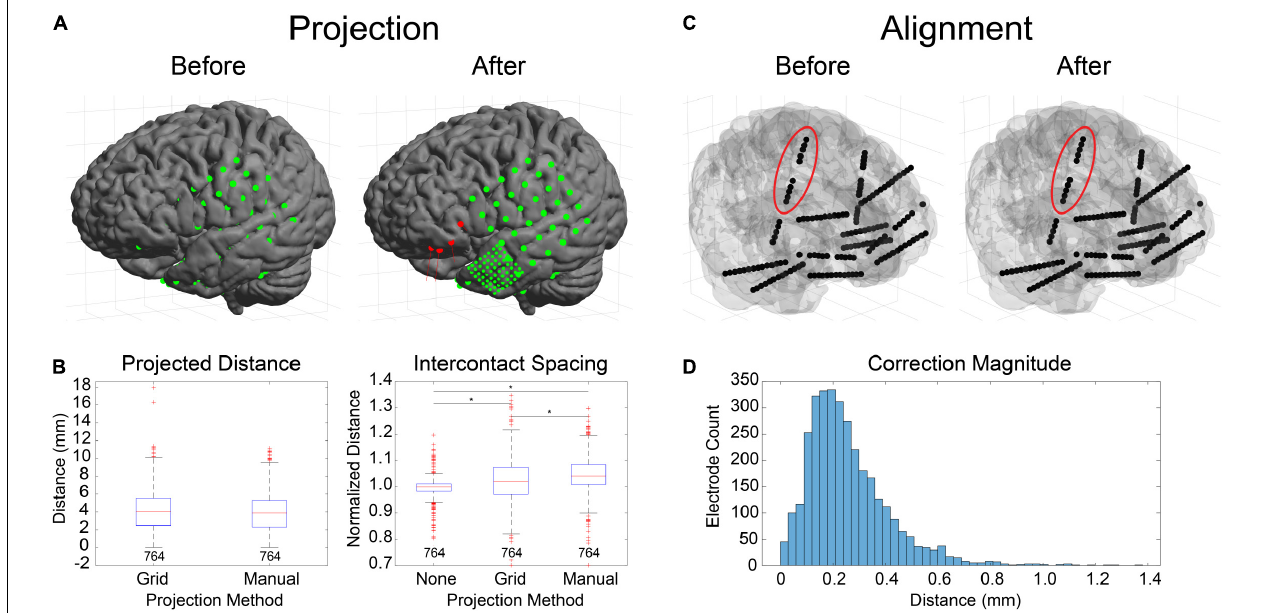
FIGURE 4 | Electrode projection and alignment results. (A) Example showing electrodes before (left) and after (right) projection using the “manual” projection method. An 8 × 8 ECoG grid and multiple strips (10-mm spacing) along with an 8 × 8 mini-ECoG grid (3-mm spacing) are visible. Projection vectors (red lines) are shown for 4 selected electrode contacts (red spheres) that represent the normal vector to the “projection” surface (not shown). (B) Projection distances for 10 datasets (764 electrodes) for the “grid” (Hermes et al., 2010) and “manual” projection methods are shown (left). The median and ranges were 4.07 (0.00–17.95) and 3.88 (0.00–11.17) mm, respectively. No differences were found between the two methods (KW test, df = 1, χ 2 = 3.14, p = 0.076). Intercontact spacings were measured for unprojected electrode contacts, as well as for the two projection methods (right). The median and ranges were found to be 1.00 (0.45–1.78), 1.02 (0.38–1.93), and 1.04 (0.44–1.99) mm, respectively. Asterisks indicate significance (pairwise rank sum, p < 0.01). Separations for the “grid” and “manual” methods were both higher than unprojected “none,” indicating expansion during the projection process. (C) Example showing electrodes before (left) and after (right) alignment process. Corrections to electrode positions were small but can be visualized in the right insular lead (red ellipse). (D) Correction magnitudes for 38 datasets (365 leads, 3726 contacts). The median and range were 0.23 (0.00–1.37). The median correction magnitude of 0.23 mm was less than the voxel resolution (0.4 mm/vox), suggesting that most corrections are for rounding errors due to the voxelization of the image.